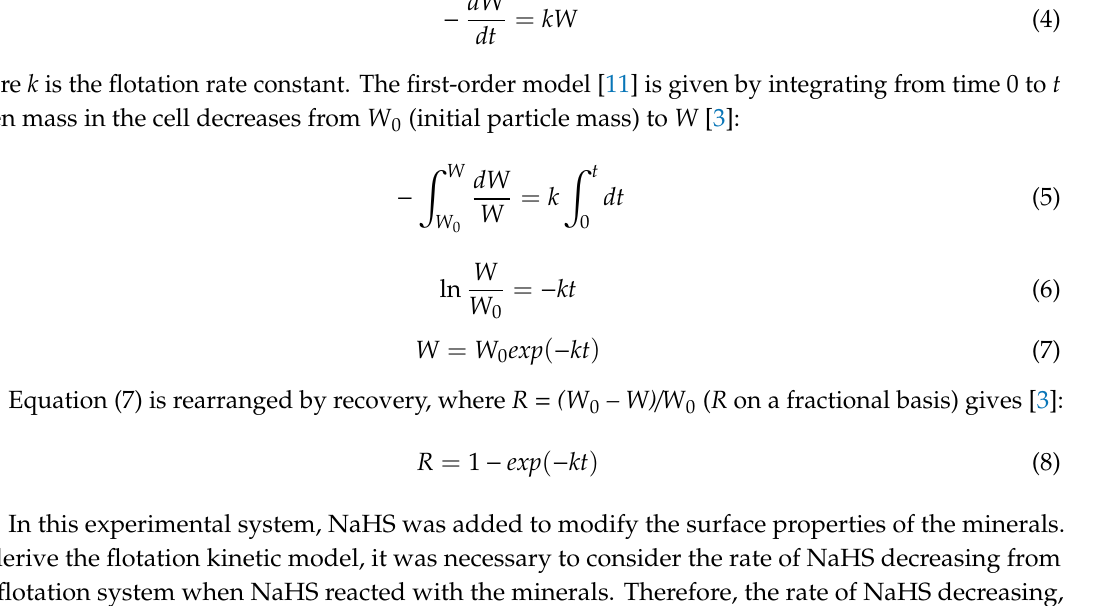
Figure 8. Chalcopyrite recoveries without NaHS and with NaHS dosages of 50 g/t, 100 g/t, and 200